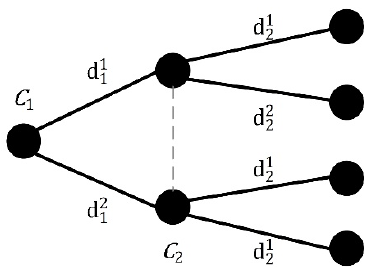
Figure 3. The extended schematic diagram of single-step game. Table 3. Pure strategies of the lane-changing game. 𝑪𝒂𝒓.𝟑 Player Lane-Changing/Accept Lane Keeping/Refuse 𝐶𝑎𝑟.0 Car